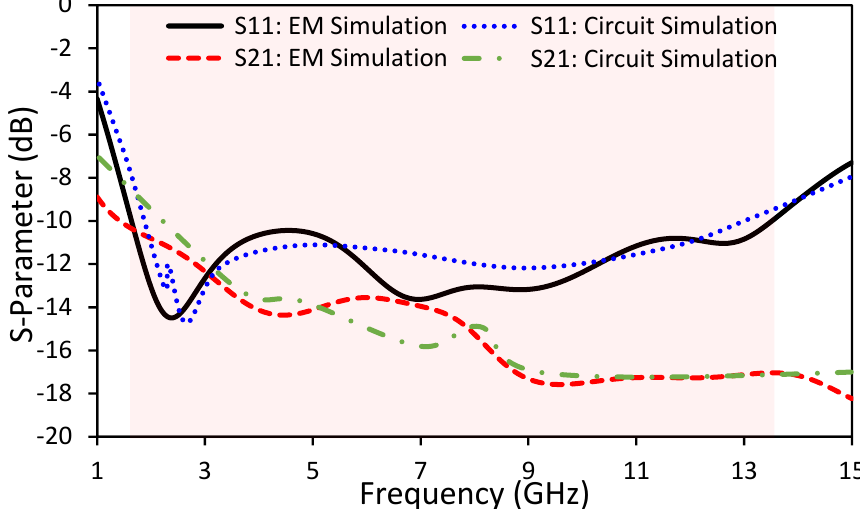
Figure 5. Lumped element equivalent circuit simulation comparison with EM simulation without decoupling